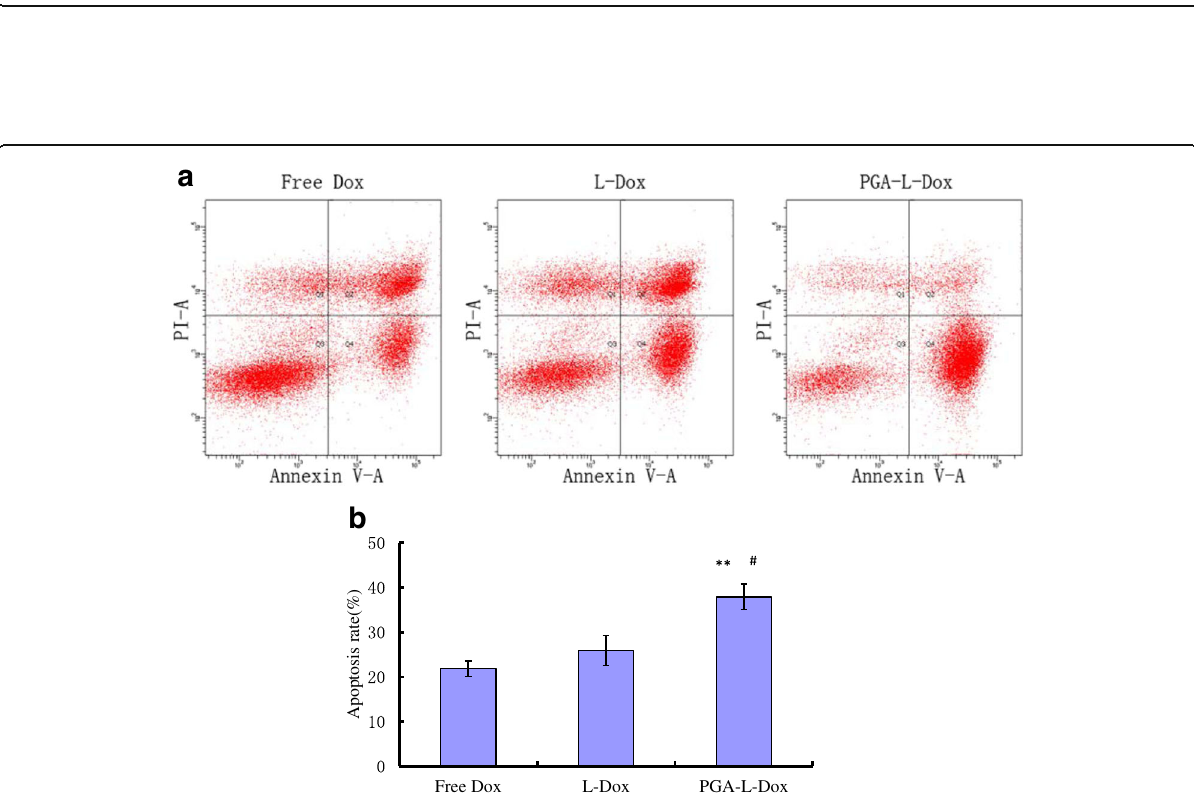
Fig. 3 Fluorescent microscopic images of ( a ) Free Dox, ( b ) L-Dox, ( c ) PGA-L-Dox. Red fluorescent signals are related to Dox and blue ones correspond to DAPI. The final images show the merged Dox and DAPI ones. Scale bar is 50.0 μ m